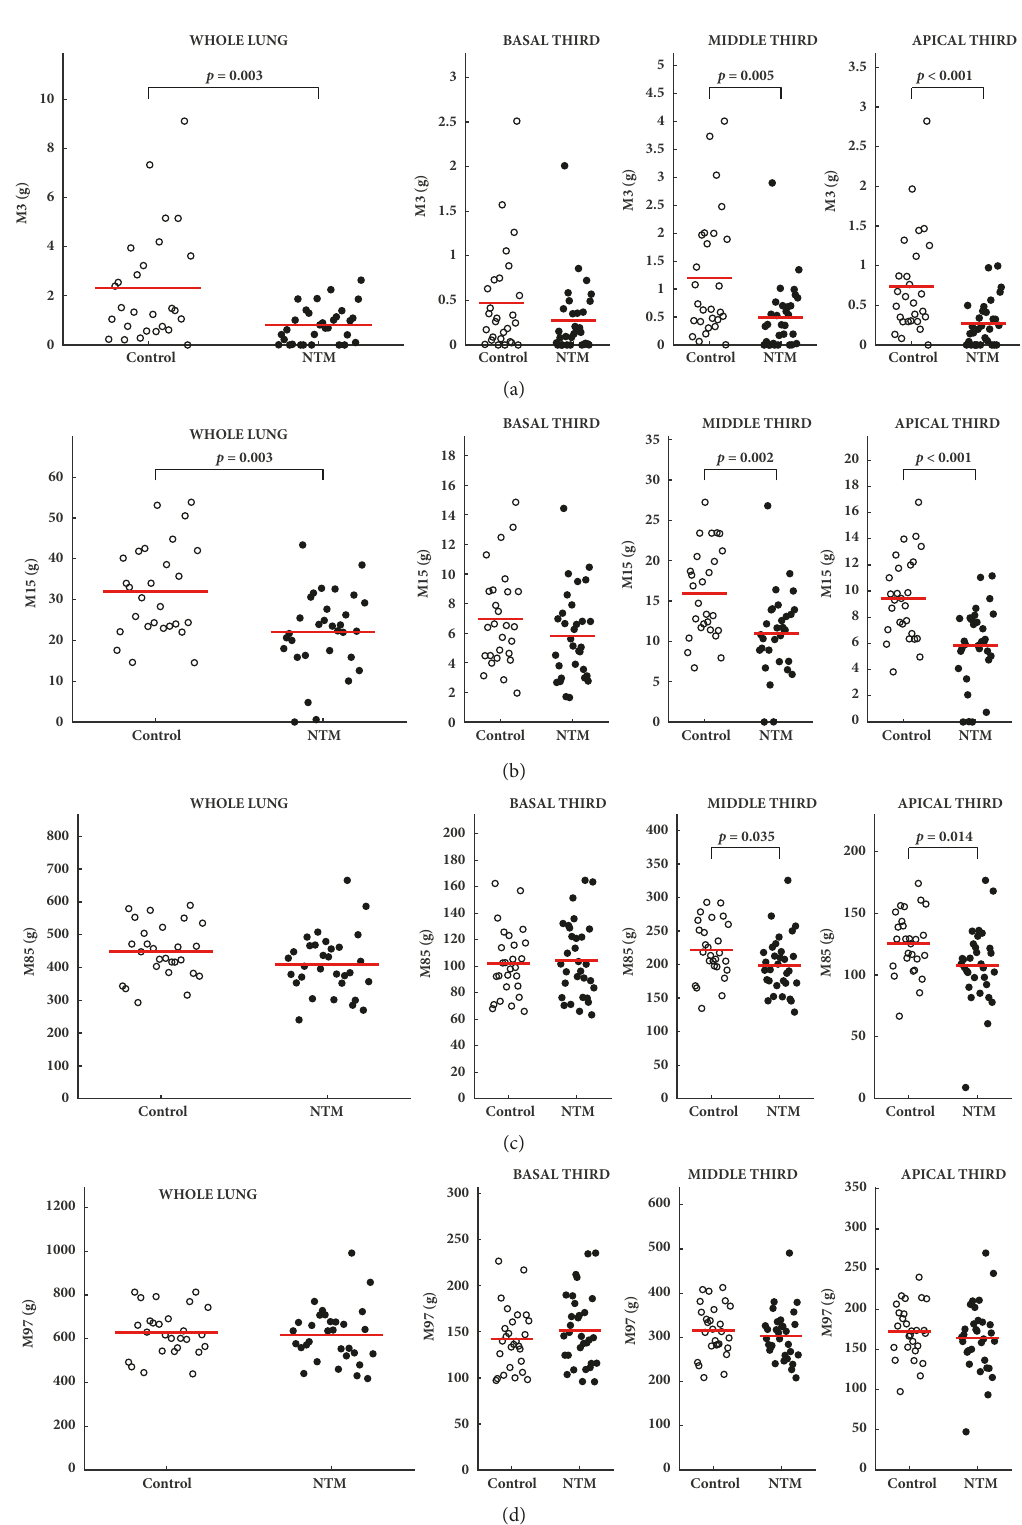
Figure 1: Comparisons between the control group and the nontuberculous mycobacteria group (NTM) for the measures of cumulative mass relations in 3% (M3) (a), 15% (M15) (b), 85% (M85) (c), and 97% (M97) (d) of the total lung